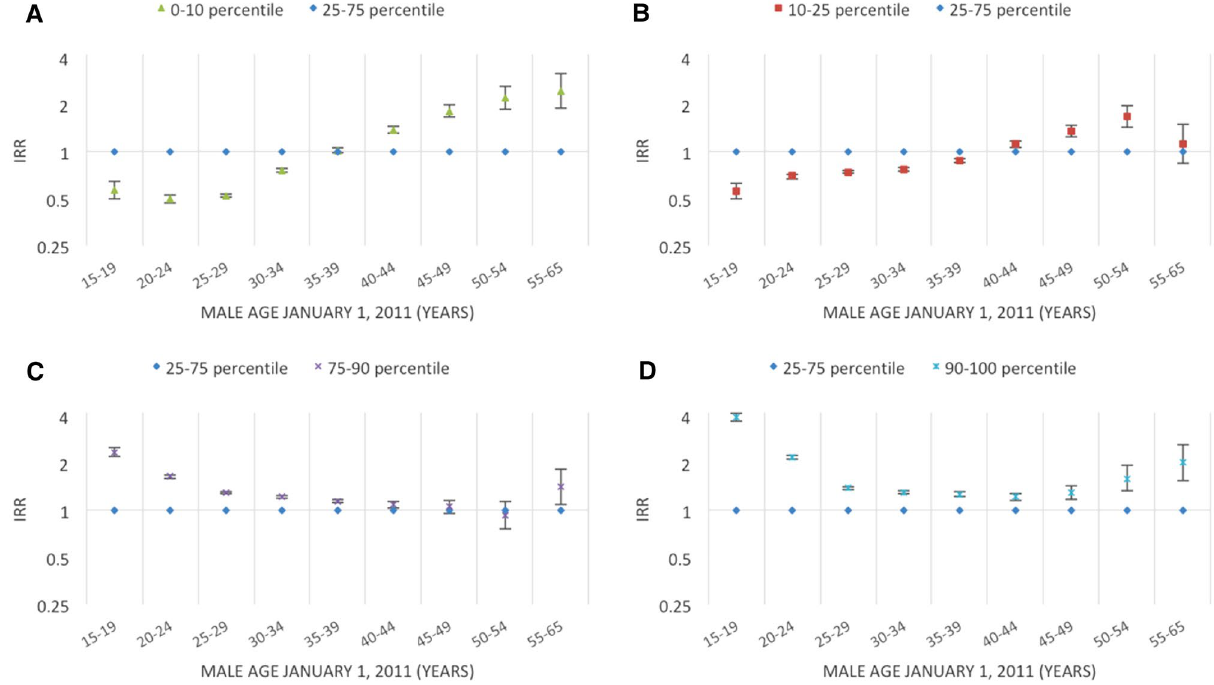
Figure 6. Incidence rate ratios (IRR) of fathering a child according to average income 1 and age 2 . Men aged 15–65 years living in Denmark January 1, 2011 to December 31, 2015. 1 The individual’s disposable income in the period from January 1, 2010 to December 31, 2010 divided into percentiles: lower 10th percentile, 10–25th percentile, 25–75th percentile, 75–90th percentile, and upper 90th percentile. 2 Age groups according to the man’s age by January 1, 2011.